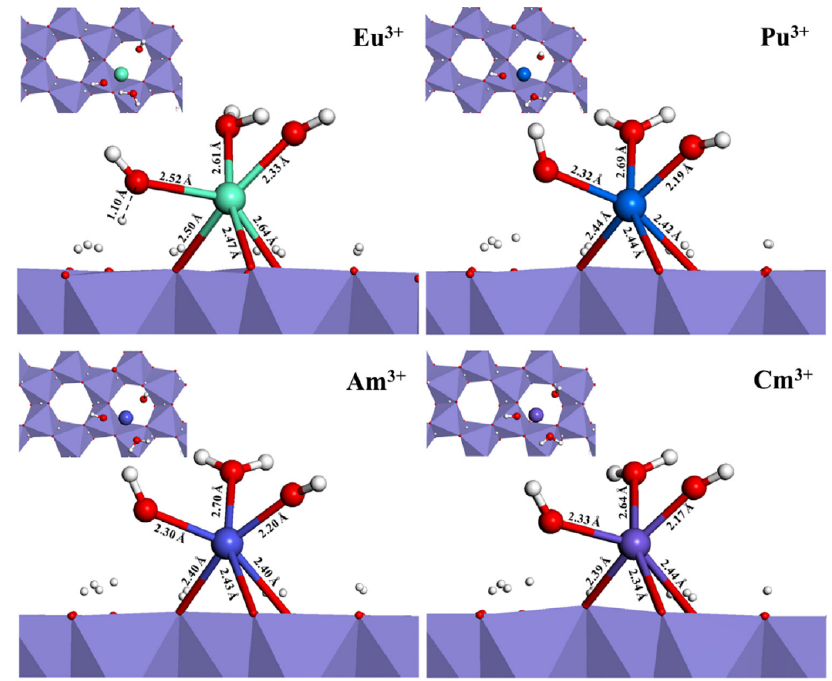
Figure 10. Ground state configuration of the [Eu/An(OH) 2 H 2 O] + complexes adsorbed on the hematite (001) surface, viewed along the [110] direction. Adsorption geometry with the lowest sorption energy for each cation is shown. Light blue is Eu, dark blue is Pu, blue purple is Am, purple is Cm, red is O, and milky white is H in order. Reprinted with permission from ref. [52]. Copyright 2021 Elsevier.